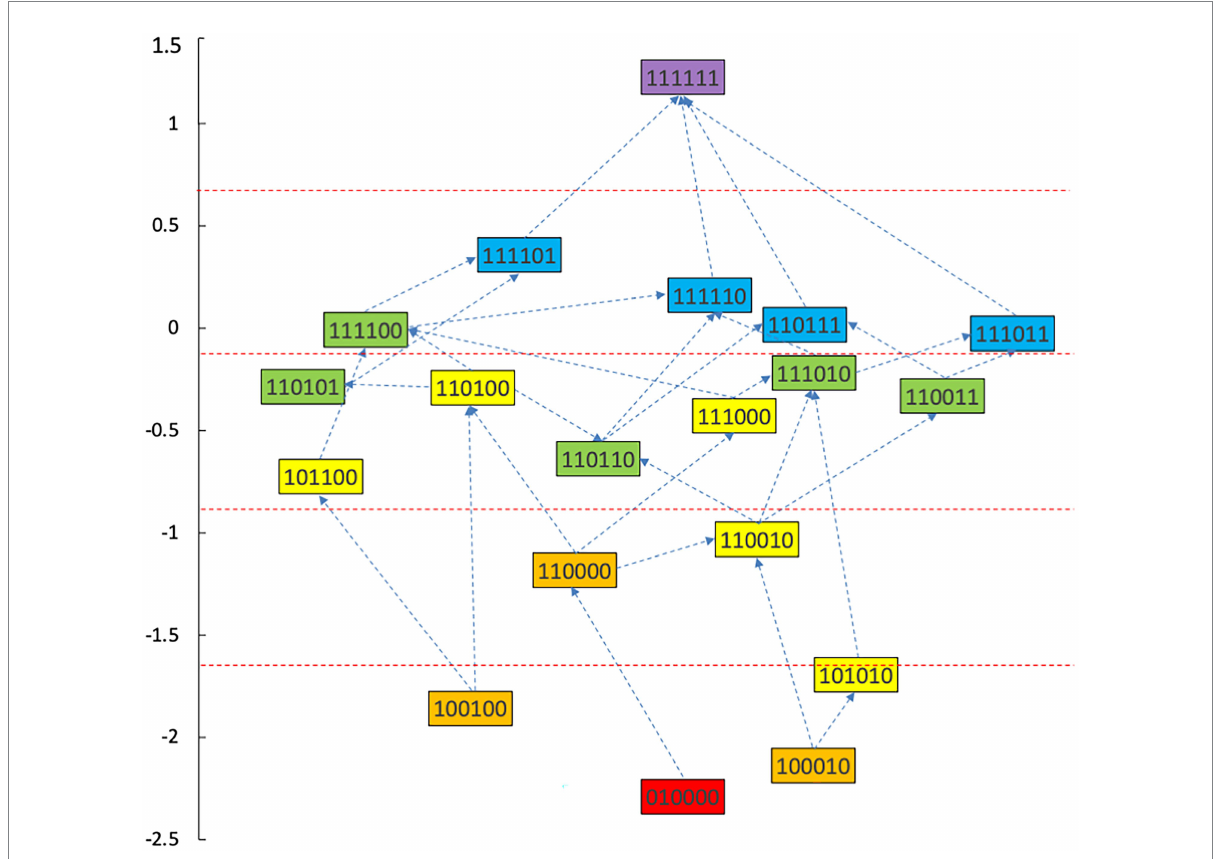
FIGURE 3 Advanced diagram of data analysis ability